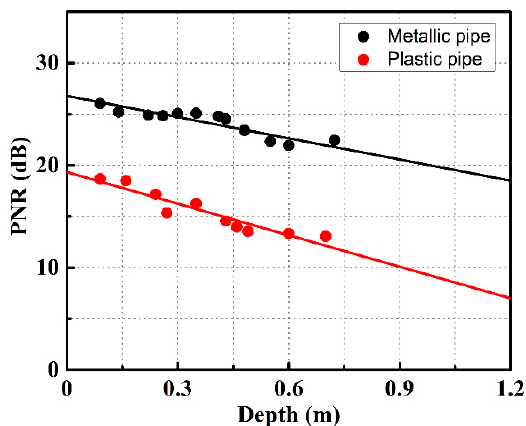
Figure 7. The PNRs of plastic pipe and metallic pipe as the function of buried depth.